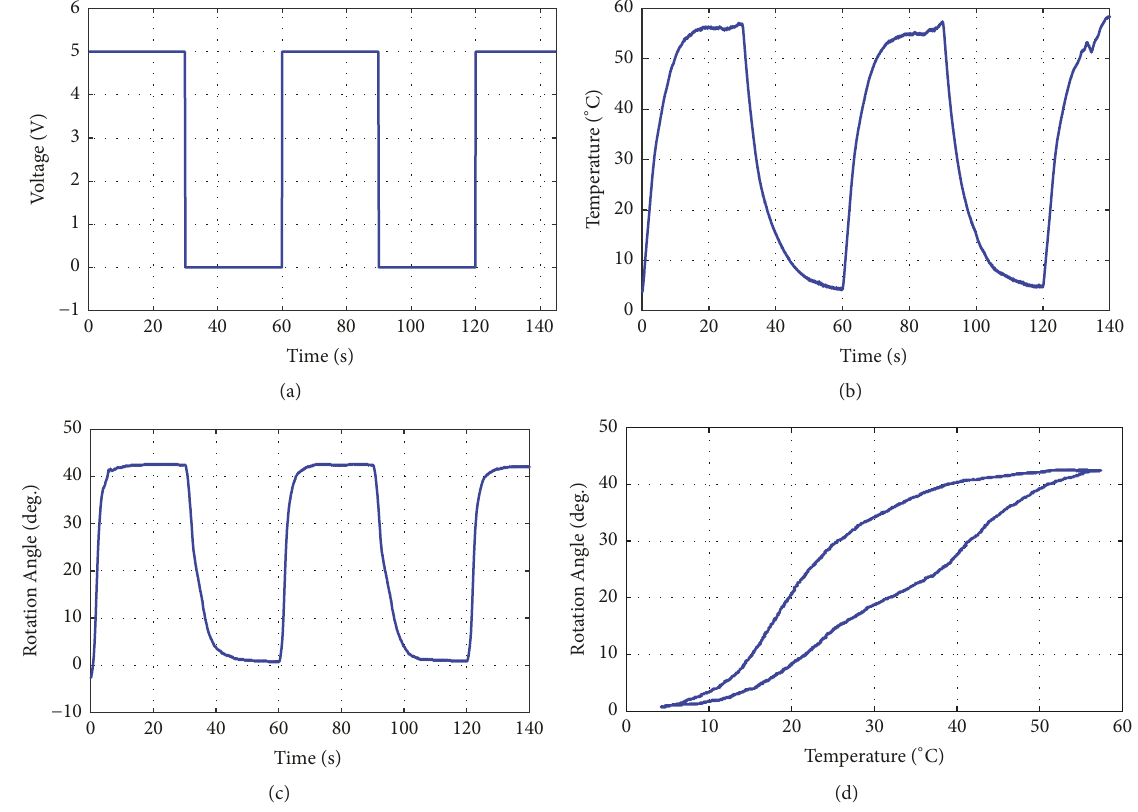
Figure 6: Input-output characteristics of the SMA-based compliant actuators under a fixed duty cycle (50%) 5v PWM signal operation with 60s signal cycle producing the temperature changing between 0 ∘ C and 60 ∘ C. (a) Input voltage. (b) Input temperature. (c) Output rotation angle. (d) Hysteresis loop.